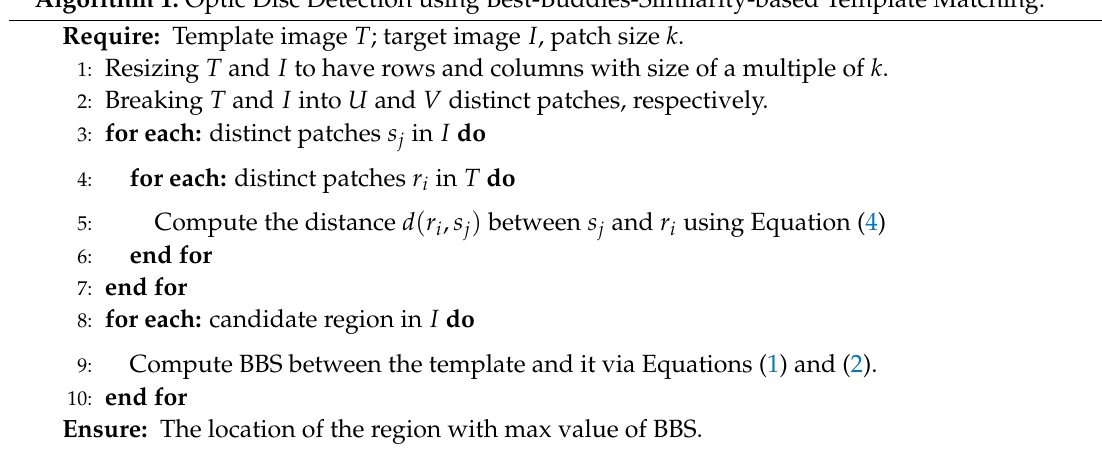
Algorithm 1: Optic Disc Detection using Best-Buddies-Similarity-based Template